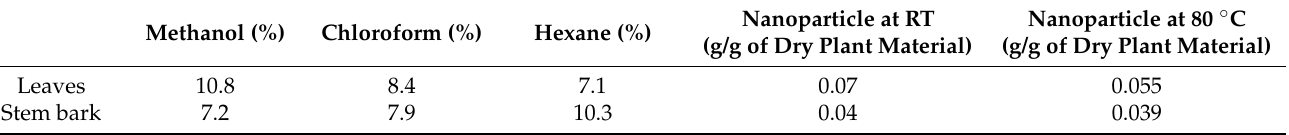
Nanoparticle at RT Nanoparticle at 80 ◦ C (g/g of Dry Plant Material) (g/g of Dry Plant Material) Literature